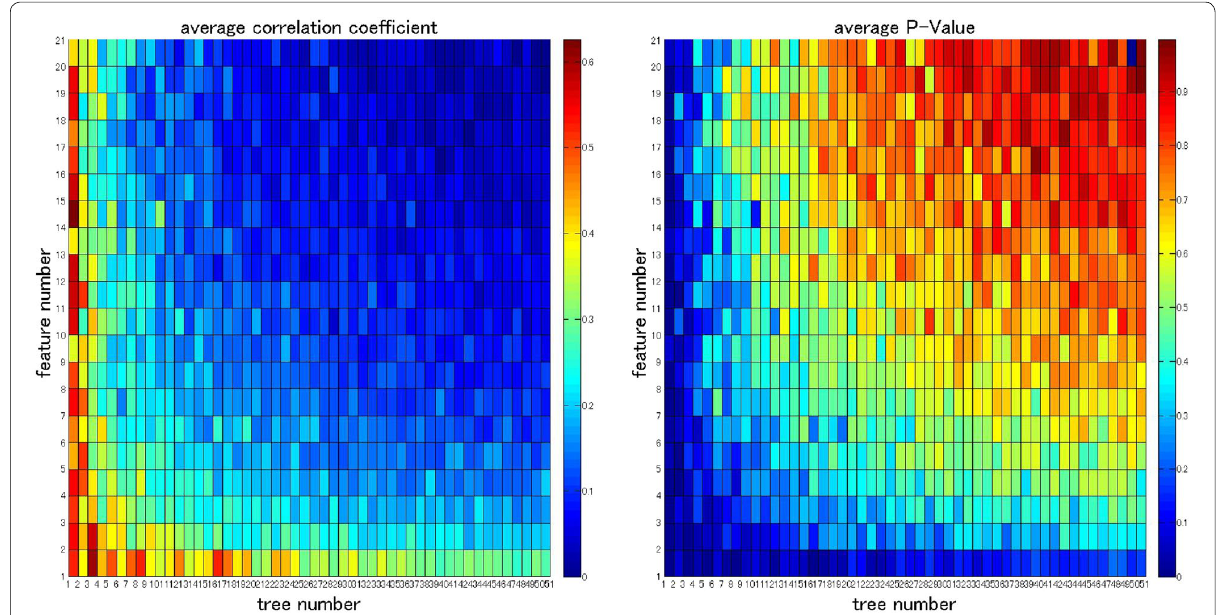
Fig. 5 Meshgrid plot of average correlation coefficient and average P value